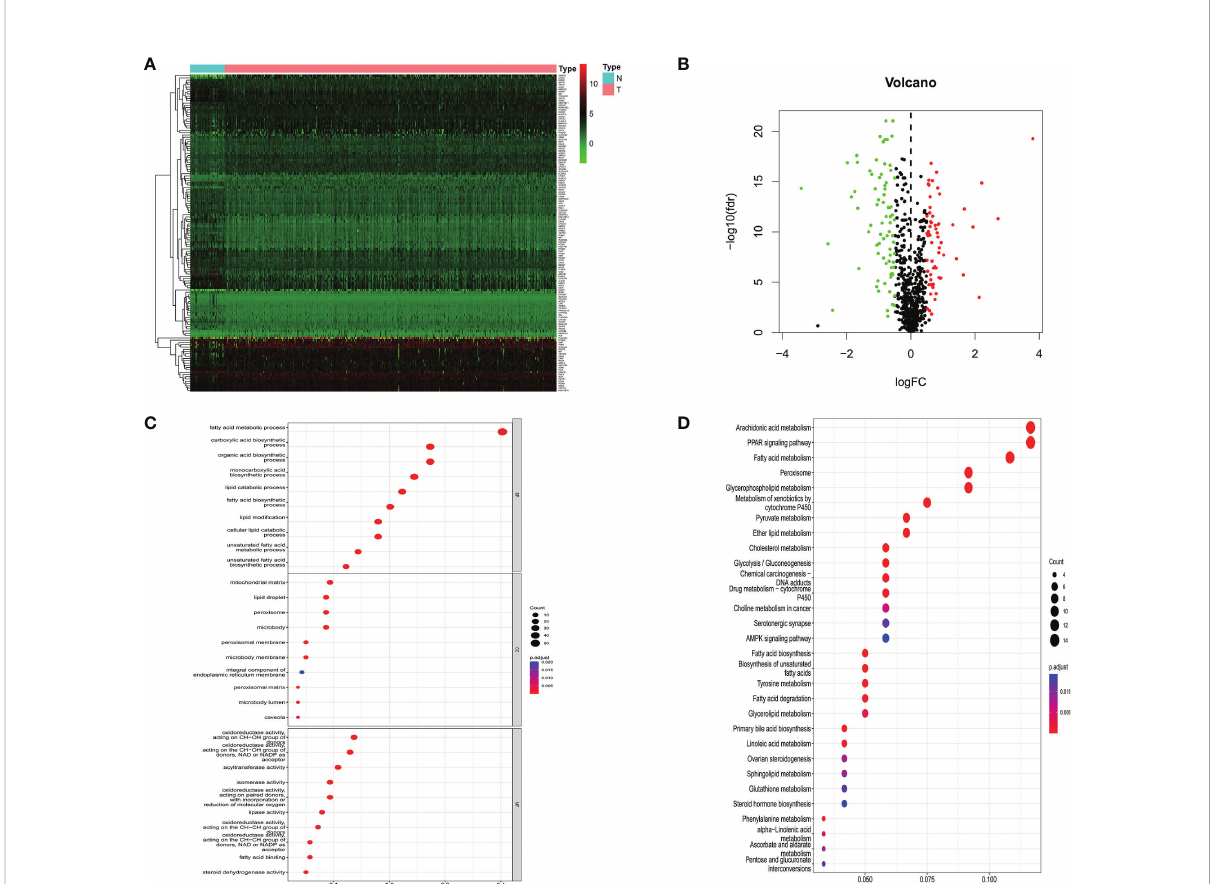
FIGURE 1 (A) Heatmap showing lipid metabolism-related genes differentially expressed in prostate cancer tissue and normal prostate tissue; (B) Volcano map of lipid metabolism-related differential genes; (C) GO analysis of related differential genes including biological processes, cellular components and molecular functions; (D) KEGG analysis of differential